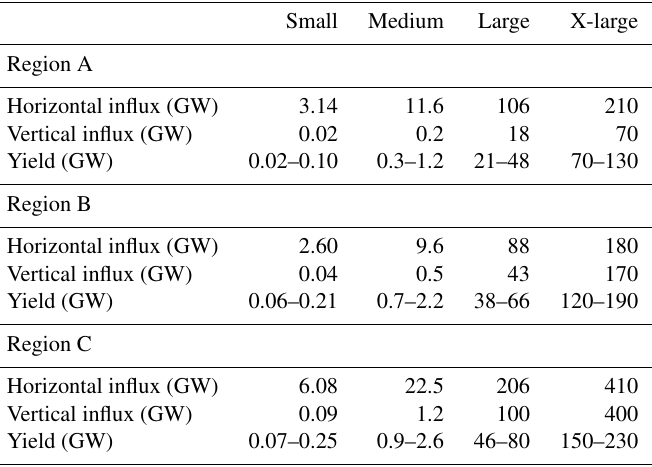
Table 5. Estimated kinetic energy influxes for the different scenarios and wind farm sizes in comparison to the estimated yields. The ranges for the “KEBA” and “Volker et al. (2017)” cases refer to the different turbine spacings (narrow, intermediate, wide) with lowest CFs and yields corresponding to the narrowest spacing and highest turbine